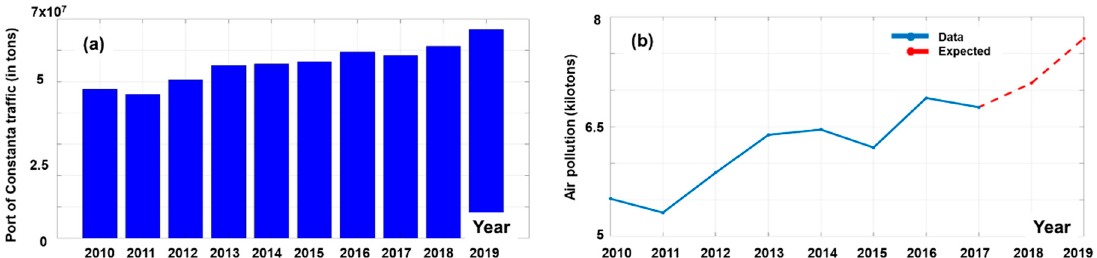
Figure 4. Port of Constanta statistics corresponding to the 20-year time interval of 2010–2019, where: ( a ) overall ship traffic—in tonnes; ( b ) air pollution (nitrogen oxides (NOx), Particular Matter (PM) and Volatile Organic Compounds (VOCs) in kilotons considering only the port activities. The air pollution associated with the years 2017, 2018 and 2019 were estimated from the existing data [21,22].